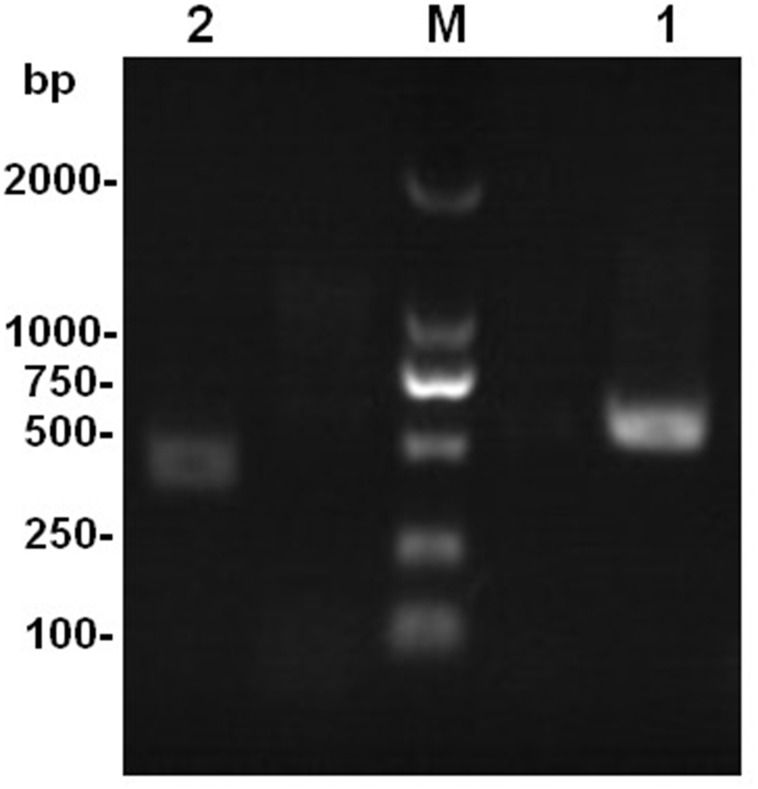
The amplification product of the rDNA-ITS gene from strains Ta-01 and Ta-02.M, DNA marker; 1, Ta-01; 2, Ta-02.